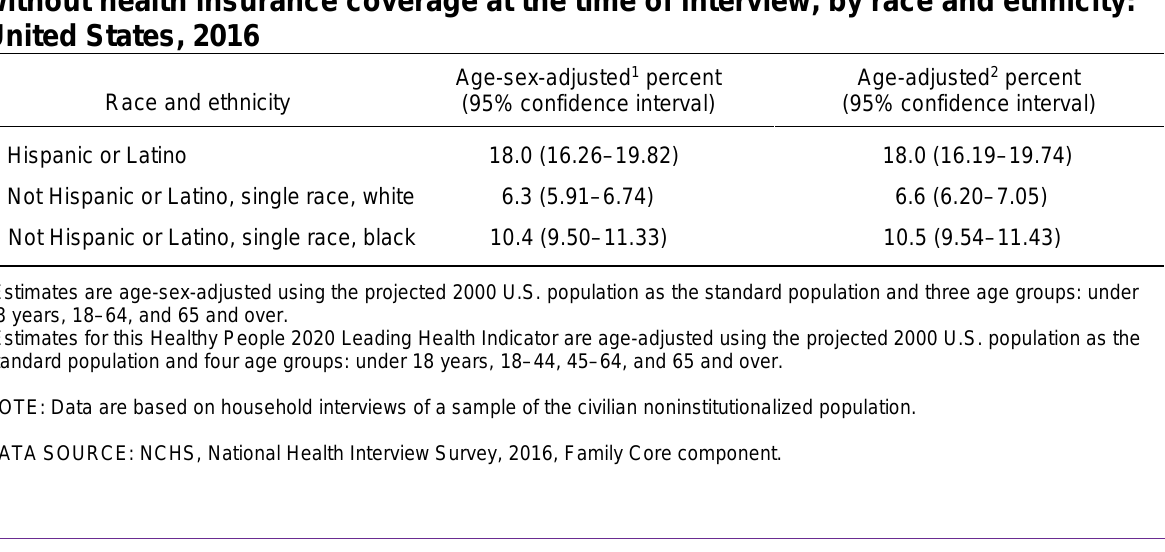
Data table for Figure 1.3. Age-sex-adjusted percentage of persons of all ages without health insurance coverage at the time of interview, by race and